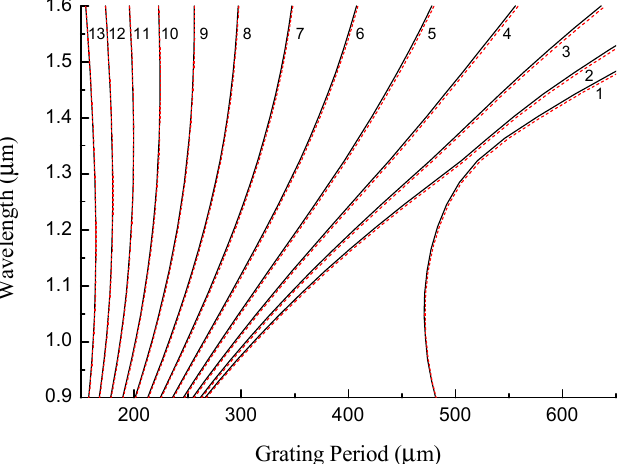
Figure 9. Dispersion curves for SMF-28 fiber for temperatures changing between 0 (red dashed lines) and 300 K (black solid lines) for cladding mode numbers j = 1...13.